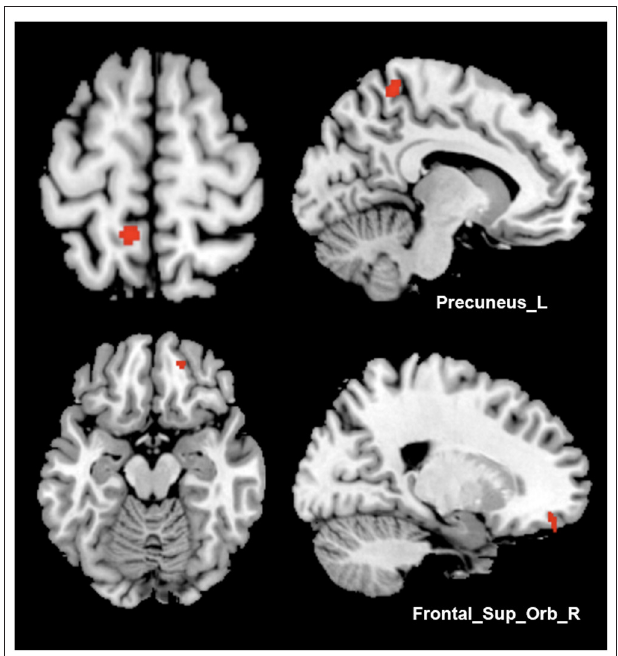
FIGURE 2 | Comparisons between different surgical outcome groups. Increased gray matter volume of the moderate-outcome group was shown in Precuneus_L and Frontal_Sup_Orb_R, compared to the superior-outcome group (axial and sagittal